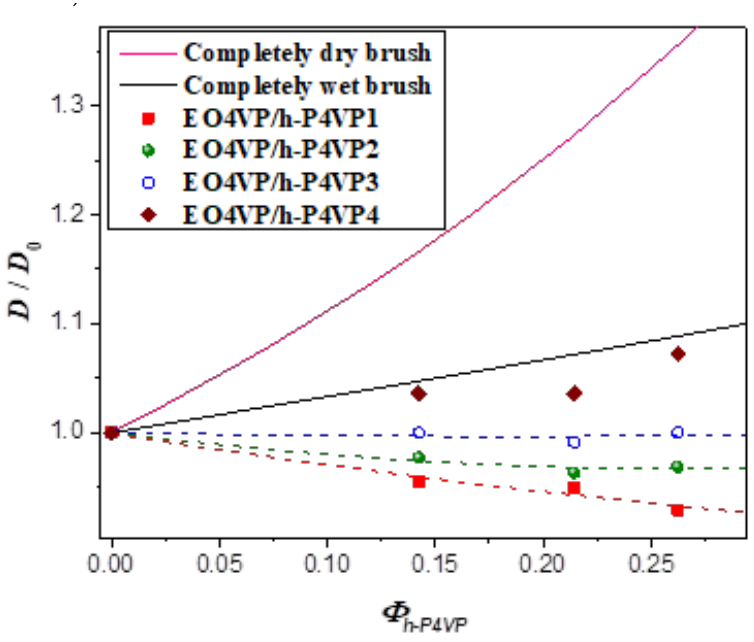
Figure 5. The normalized interdomain distance D / D 0 as a function of the overall volume fraction of h-P4VP Φ h-P4VP of the blends at 180 °C. The solid curves represent the normalized interdomain distances calculated for the scenarios of dry-brush and wet-brush behavior with the assumption of unperturbed surface free energy.